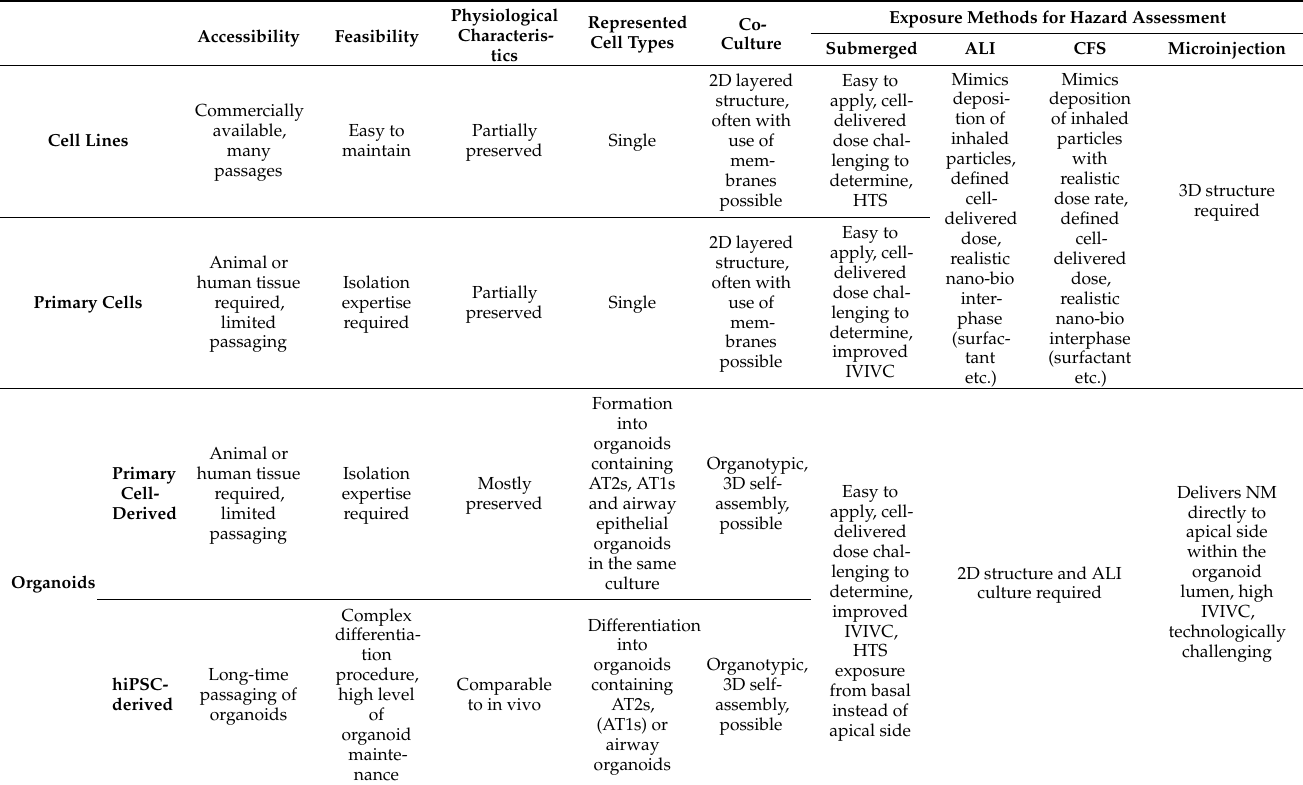
Table 1. Comparison of cell lines and organoids and exposure